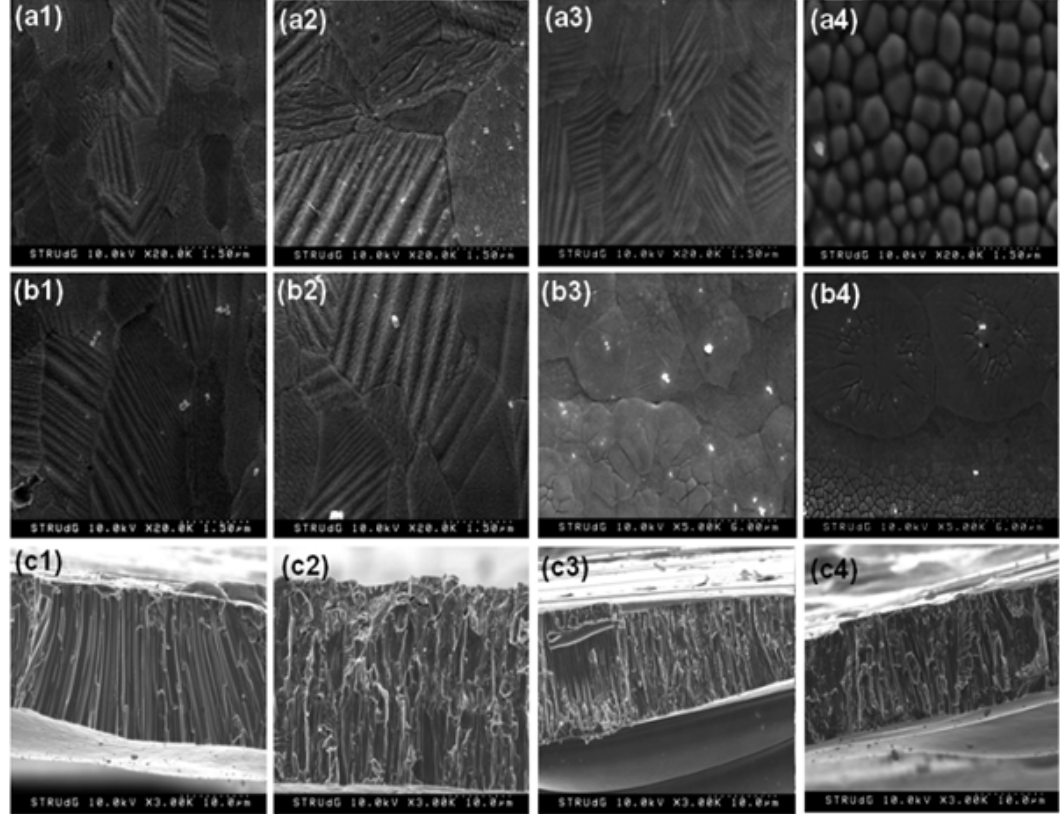
Figure 3. Typical SEM micrographs of the different regions: ( a1 – a4 ). Wheel surfaces, ( b1 – b4 ). Free surfaces and ( c1 – c4 ). Fractured cross-sections of samples labeled Sn10, Sn11, Sn12, and Sn13, respectively.